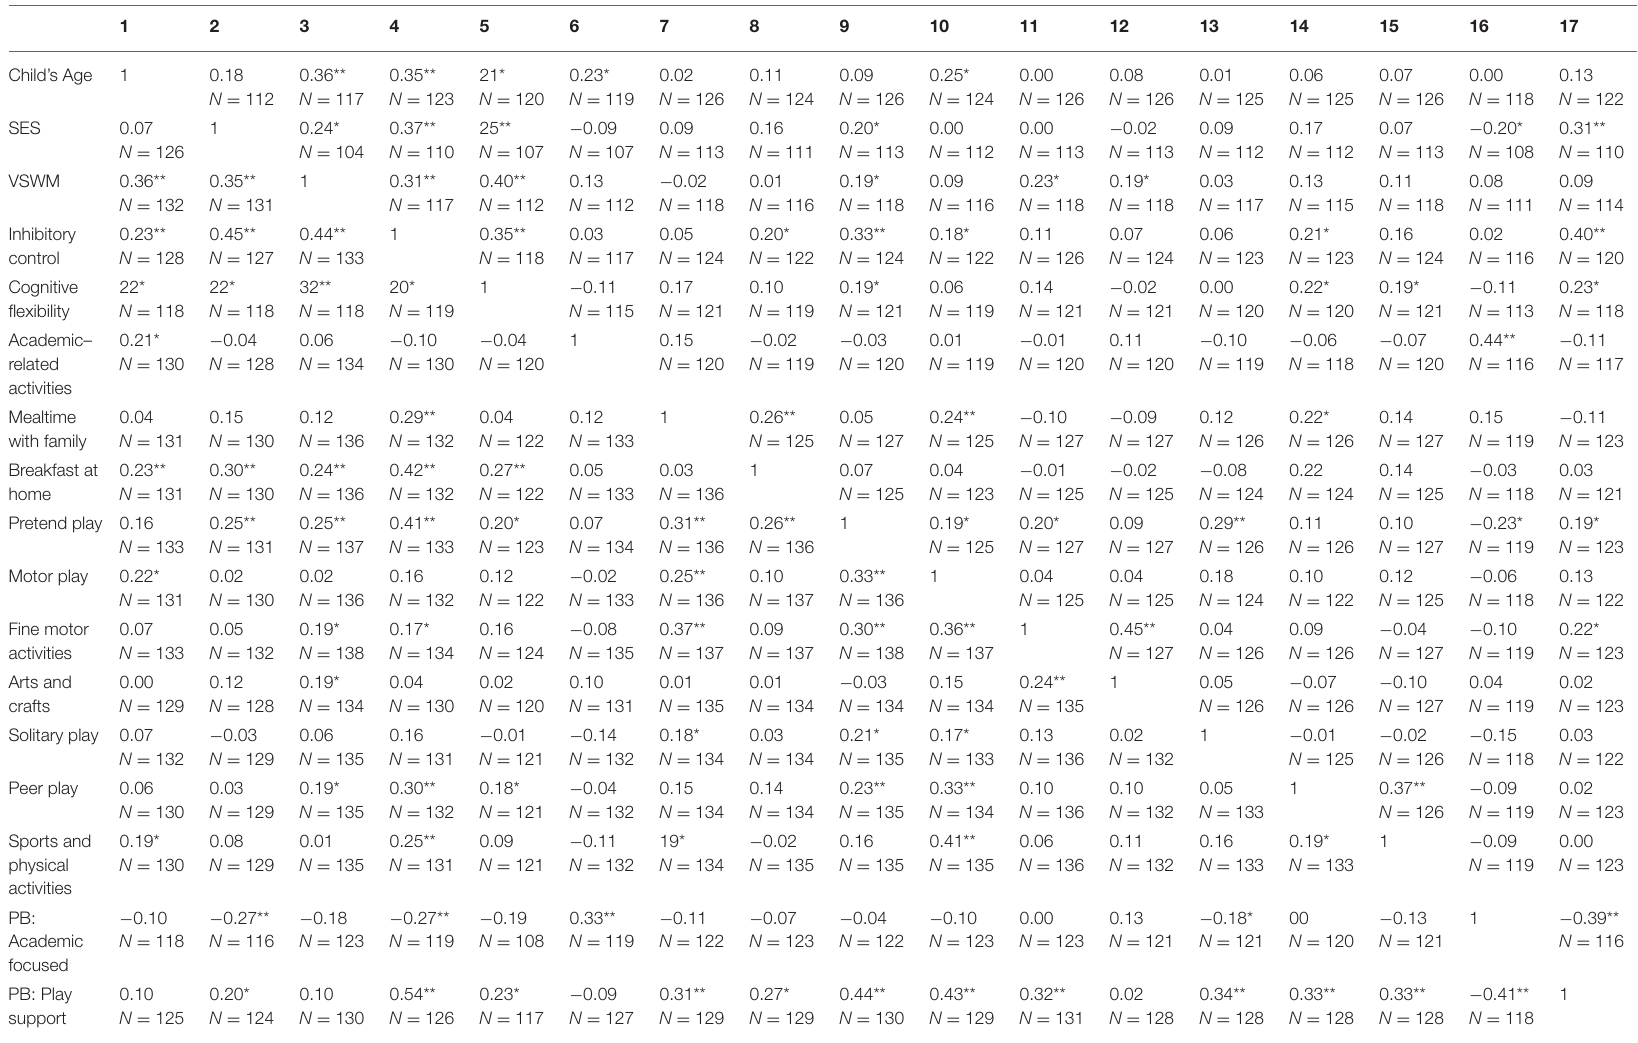
TABLE 6 | Bivariate correlations among demographics, home activities, parental play beliefs, and executive functions variables for Ethiopian and Hungarian